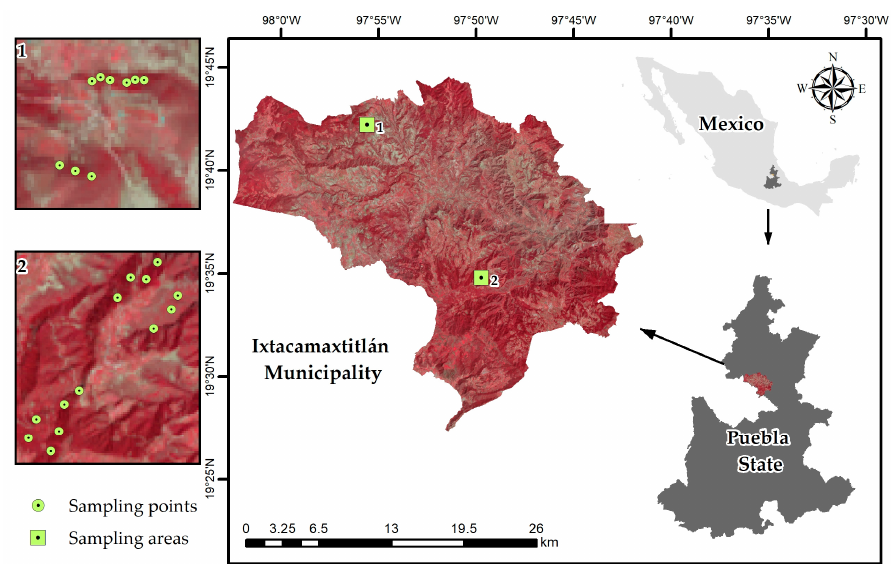
Figure 1. Location of the study site, sampling areas and sampling points in Mexico. The color composite (Bands 5,4,3) of Landsat 8 from 7 October 2020.